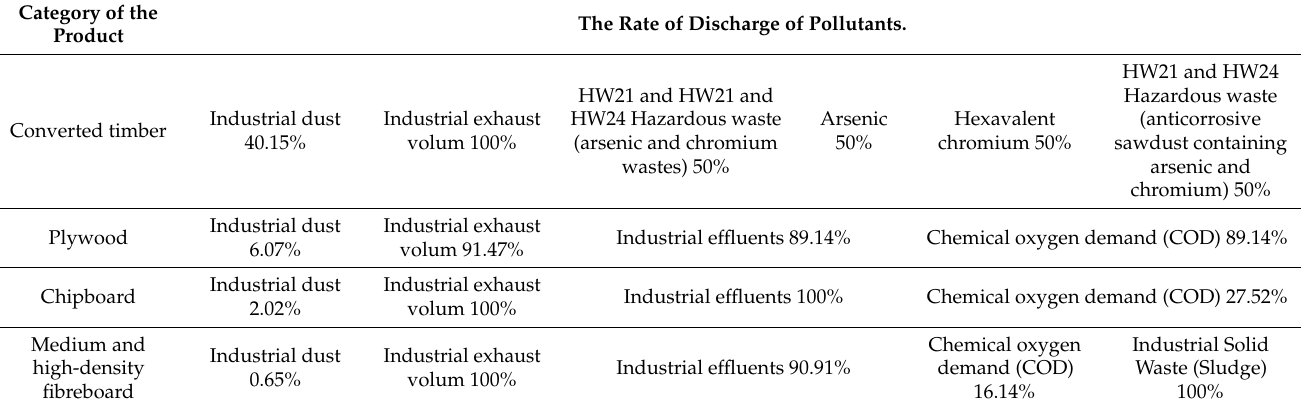
The Rate of Discharge of